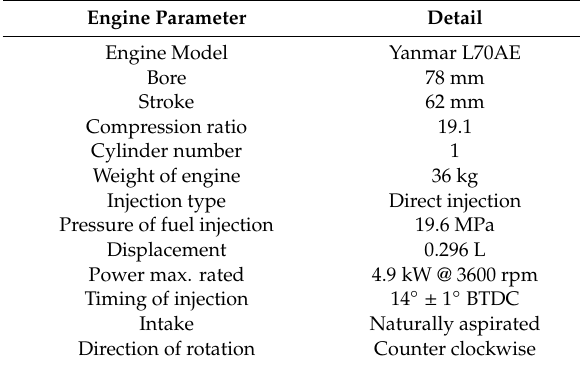
Table 1. YANMAR L70AE CI generator diesel engine technical